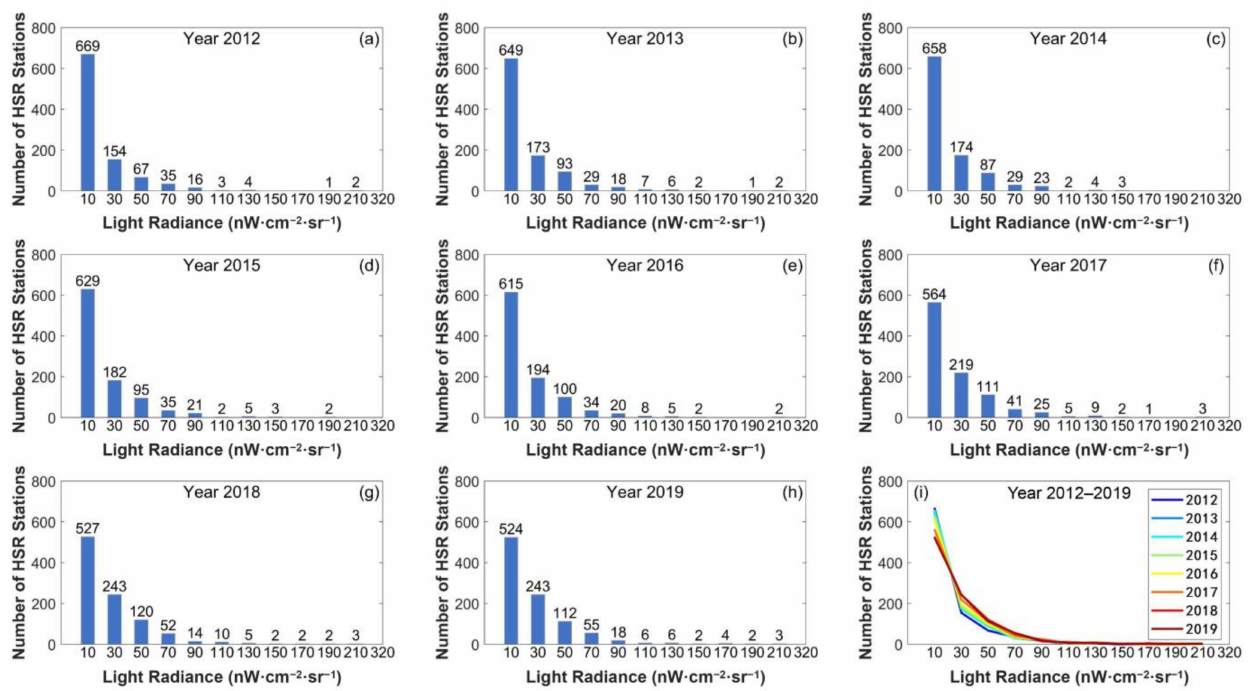
Figure 4. Light brightness of HSR stations from 2012 to 2019. ( a – h ) Frequency distribution histogram of brightness for each year from 2012 to 2019 and ( i ) variation curve of the number of stations with brightness from 2012 to